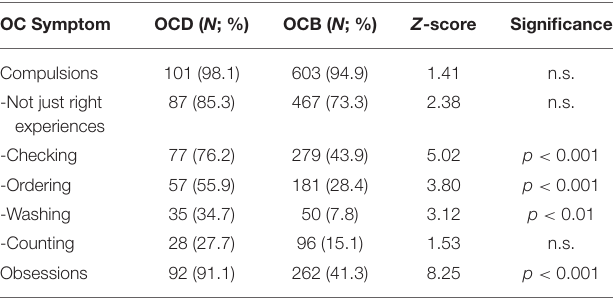
TABLE 8 | Prevalence rates of different forms of OC symptoms in TS patients with comorbid OCD compared to those with comorbid OCB.